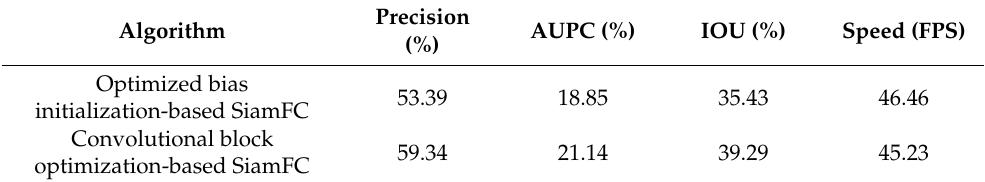
Table 2. Overall results of the proposed convolutional block initialization and activation-based implementation.